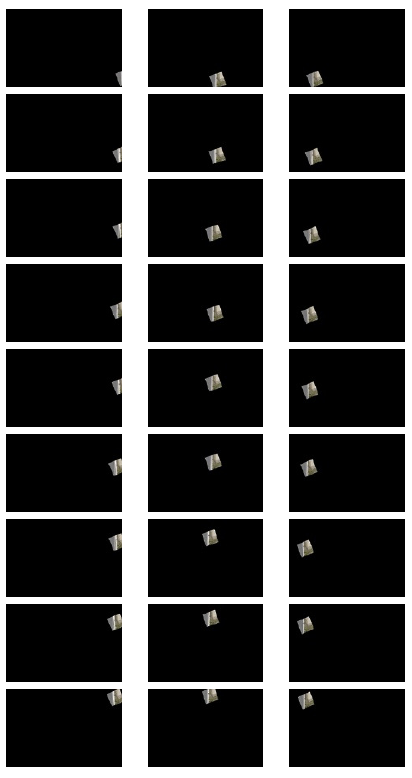
Figure 2. UAV images photographing the ROI in Figure 1